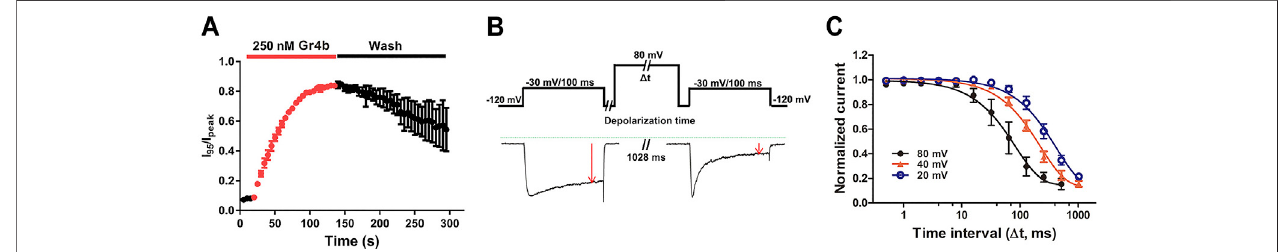
FIGURE 4 | Kinetics of dissociation of Gr4b from Na v 1.9. (A) Time course of the inhibition of fast inactivation by 250 nM Gr4b and the recovery upon washing with bath solution, in which the ratios of I 95 /I peak were plotted as a function of time, τ on (cid:2) 42.8 ± 3.5 s (n (cid:2) 3). (B) Diagram showing the protocol for dissociation analysis ( upper ). Representative current showing in the presence of 0.25 μ M Gr4b, progressively prolonged strong depolarization (to 80 mV) led to a greater degree of Na v 1.9 current recovery from Gr4b inhibition ( below ). (C) Time course of dissociation of 250 nM Gr4b from Na v 1.9 at 80 mV ( τ (cid:2) 105.6 ± 36.3 ms, n (cid:2) 4), 40 mV ( τ (cid:2) 240.0 ± 26.9 ms, n (cid:2) 4), and 20 mV ( τ (cid:2) 473.5 ± 90.8 ms, n (cid:2) 4). Cells expressing Na v 1.9 were incubated in Gr4b for 110 s at a holding potential of − 120 mV to allow binding. The rate of toxin dissociation was determined with the illustrated pulse paradigm by stepping to a depolarizing pulse of 80, 40, or 20 mV for 0 – 1,028